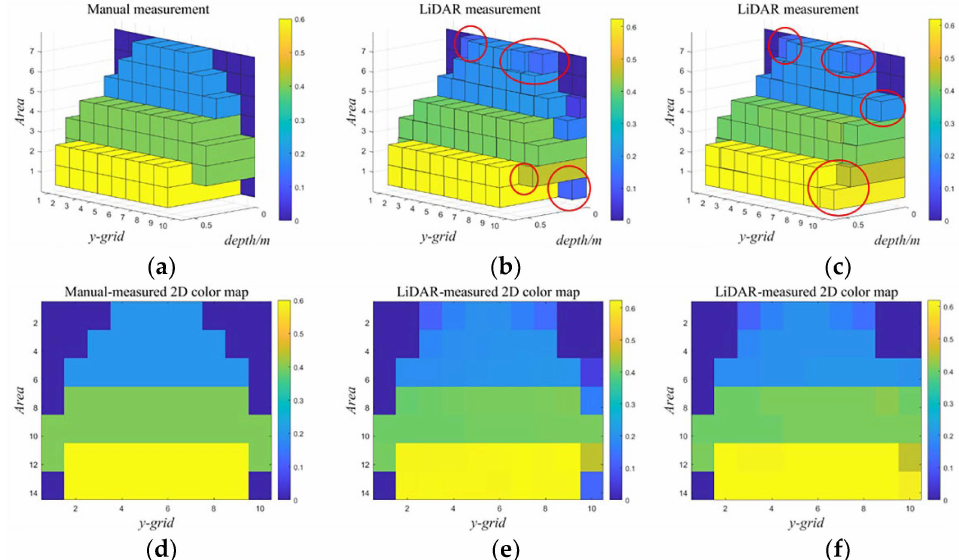
Figure 7. LiDAR measurement vs. ground truth: ( a ) manually measured 3D colour map; ( b ) LiDAR-measured 3D colour map (average depth); ( c ) LiDAR-measured 3D colour map (maximum depth); ( d ) manually measured 2D colour map; ( e ) LiDAR-measured 2D colour map (average depth); ( f ) LiDAR-measured 2D colour map (maximum depth). Note: The red circles in the figure refer to the edge grids that can detect the canopy depth.